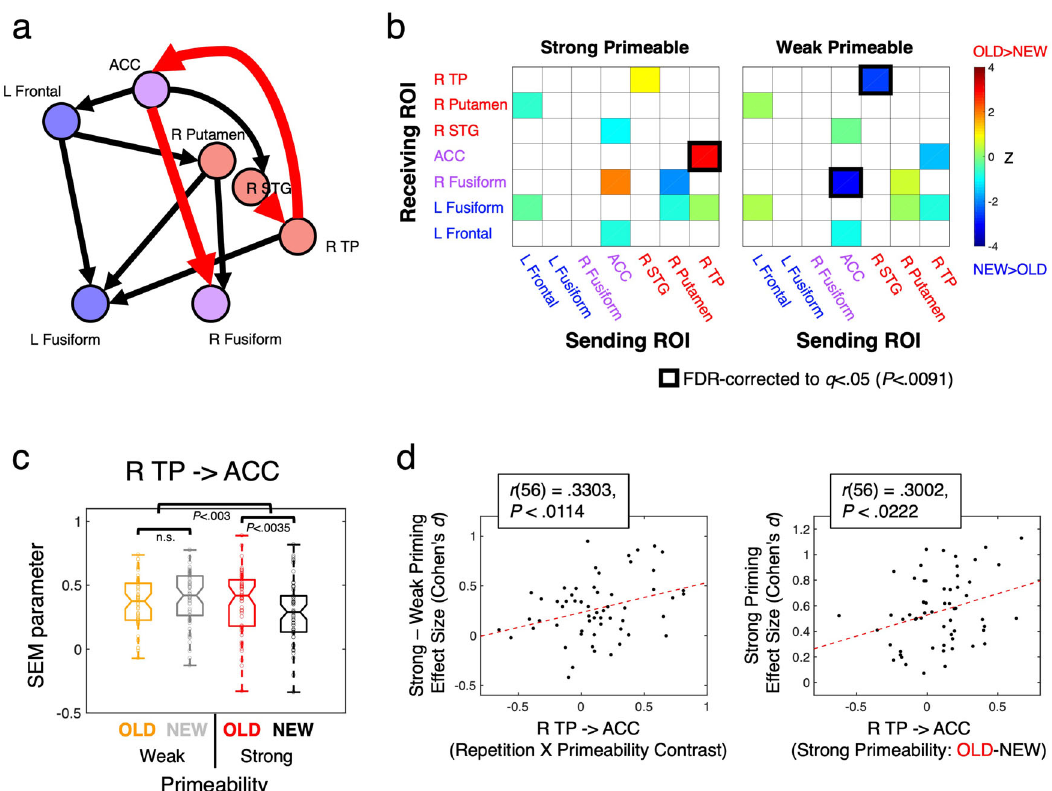
Fig. 7 Effective connectivity increases between R TP cortex and ACC correlate with priming magnitude. a Structural equation modeling (SEM) was used to estimate effective connectivity among the 7 regions. The optimal 10-parameter SEM model is shown, with arrows indicating causal directionality and connections exhibiting a signi fi cant Repetition × Primeability interaction ( P < 0.0063, q < 0.05) shown with thick red arrows (non-signi fi cant interactions shown with black arrows). b Region-by-region comparisons of SEM parameters for OLD versus NEW objects are shown separately for the Strong and Weak Primeable conditions. For directionality, sending ROIs are listed along the x -axes and receiving ROIs are listed along the y -axes. FDR-corrected OLD/ NEW comparisons ( P < 0.0091, q < 0.05) were assessed among connections exhibiting a Repetition× Primeability interaction, indicated with black squares. c The connection from the R TP ROI to ACC ROI shows a Repetition× Primeability interaction that is consistent with the Synchrony model (with increased coupling for OLD objects in the Strong Primeable condition). The middle horizontal line in each box plot represents the median (50th %ile), the horizontal lines just below and above the median represent the 25th and 75th %iles, the bottom and top horizontal lines represent the minimum and maximum values, and the boundaries of the horizontal notches inside the 25th and 75th %iles depict the 95% con fi dence limits of the median. Individual datapoints are plotted as open circles. d The R TP to ACC connection further exhibited a correlation across participants with observed priming magnitude, assessed by effect size (Cohen ’ s d ). This correlation appeared to be driven by the Strong Primeable condition (rightmost panel), with priming effect size in the Strong Primeable condition correlated with the difference between OLD and NEW SEM parameters in the Strong Primeable condition. Statistics are based on N = 60 independent participants, organized into a factorial design with Task (Overt, Covert Naming) as a between-participant variable (Primeability and Repetition are both within-participant variables). For related content in SI, see Supplementary Fig.